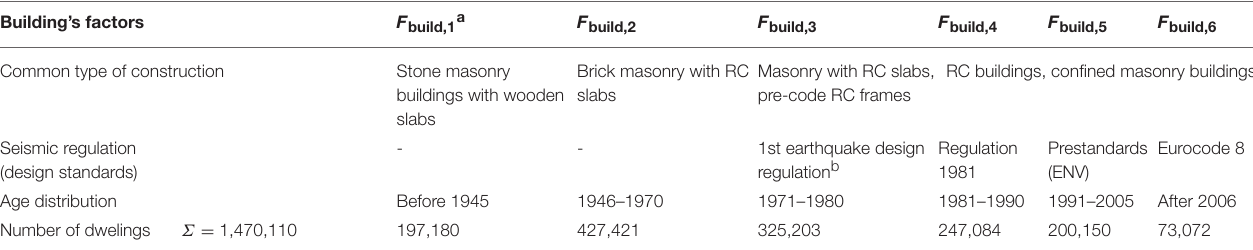
TABLE 1 | Classification of buildings by construction age, with appurtenant type of construction and seismic regulations for Croatia (Kalman Šipoš and Hadzima-Nyarko, 2018).